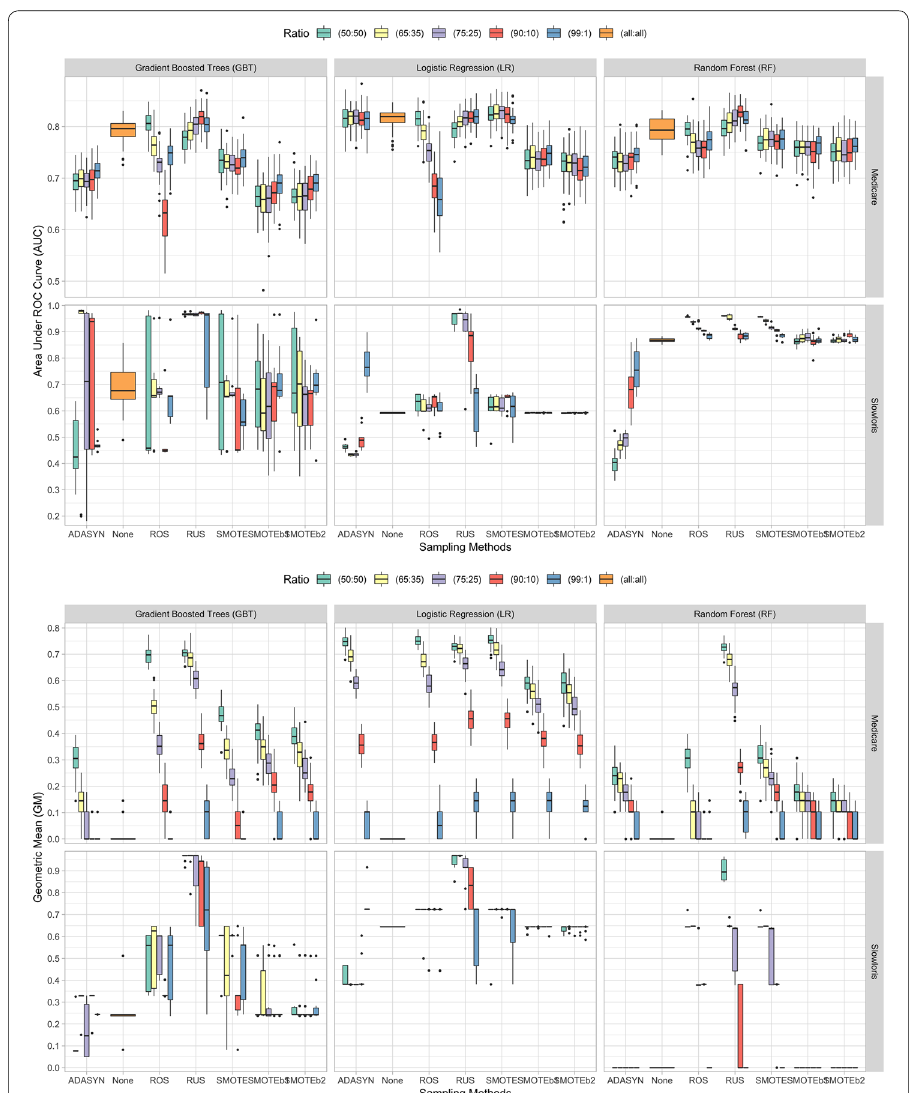
Fig. 3 Box Plot data distribution for all